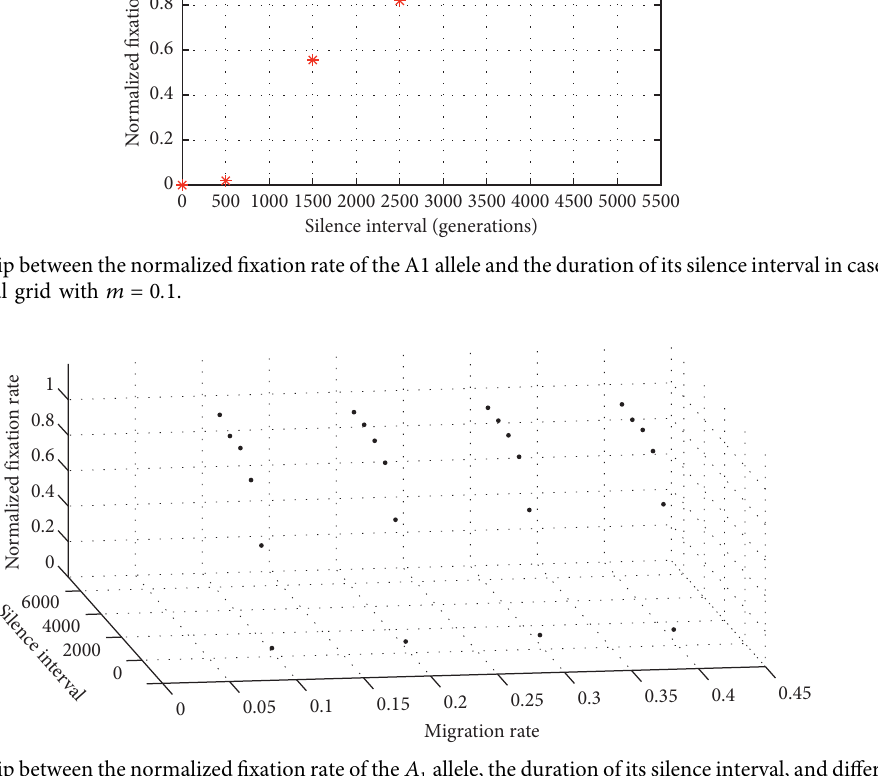
allele, the duration of its silence interval, and different values of the 1